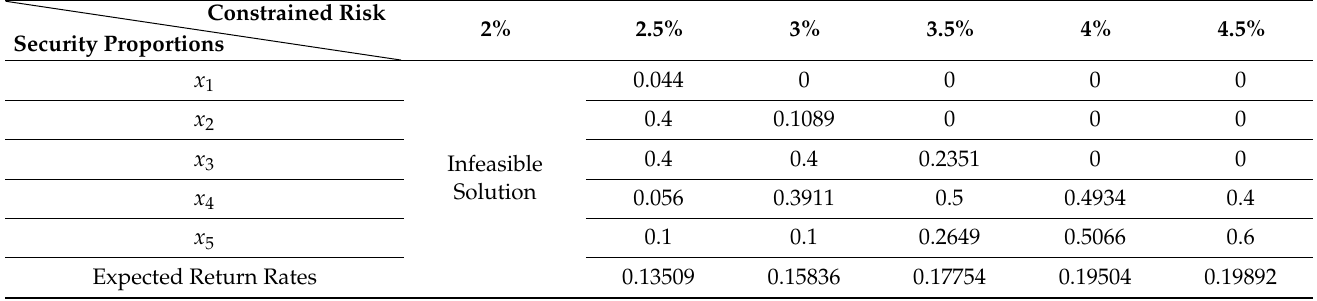
Table 6. The dimension with t = 3 and s = 2 with a guaranteed return rate (cid:101) p 3 in the proposed